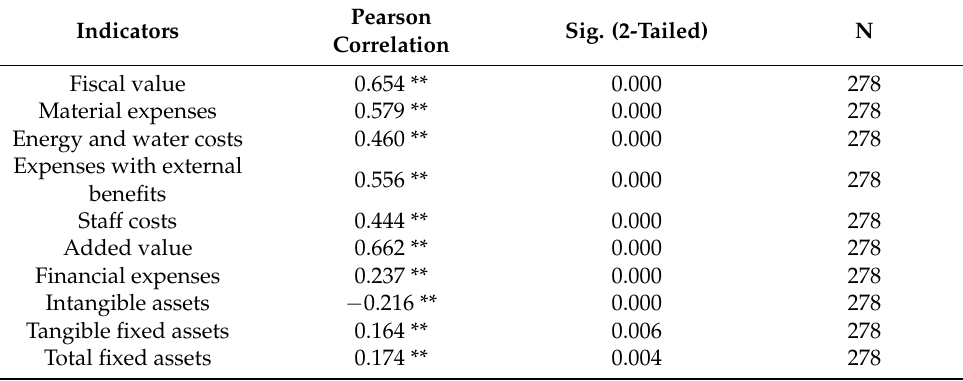
Table 1. Matrix of correlations between the dependent variable net profit and the possible indepen- dent variables in the